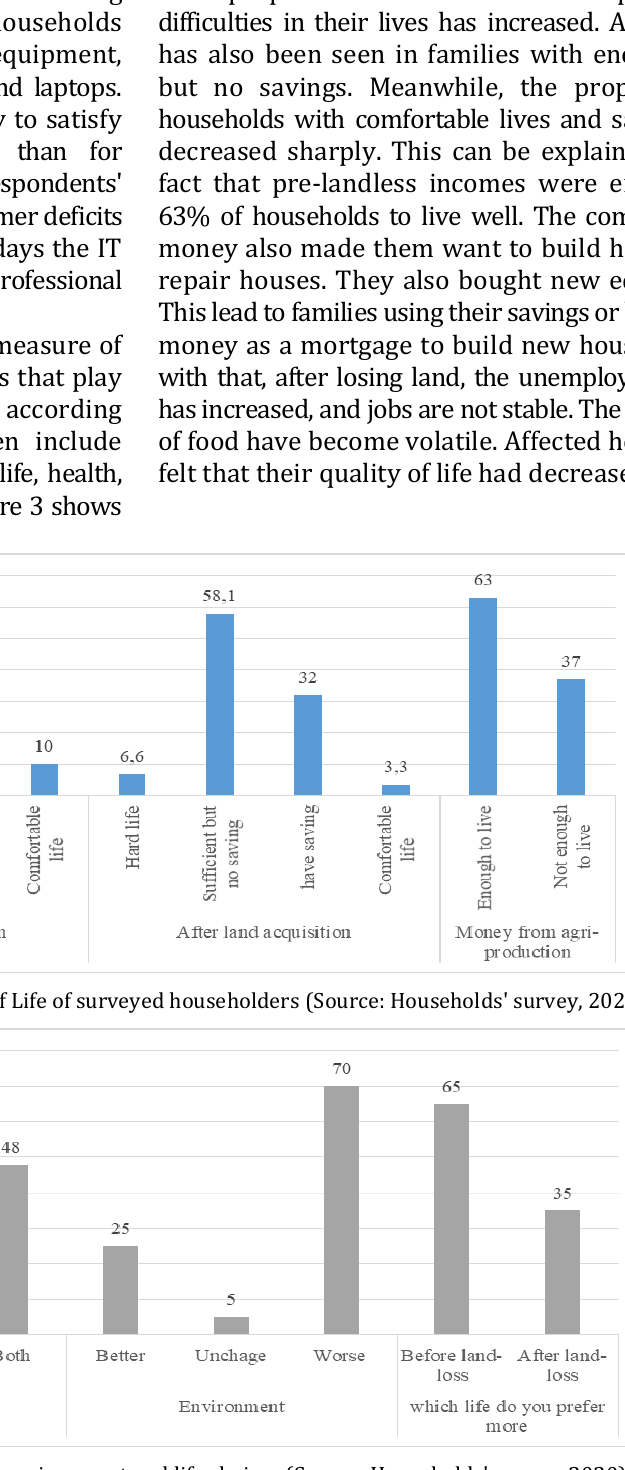
Fig. 4. Perspectives on urbanization, environment and life choices (Source: Households' survey,